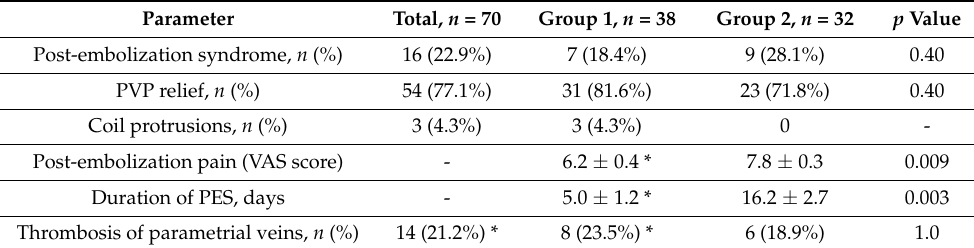
Figure 2. Duplex ultrasound scanning. Hyperechoic structures (coils) in the lumen of the gonadal vein (arrows). Table 2. Main results of the study and comparison of groups.